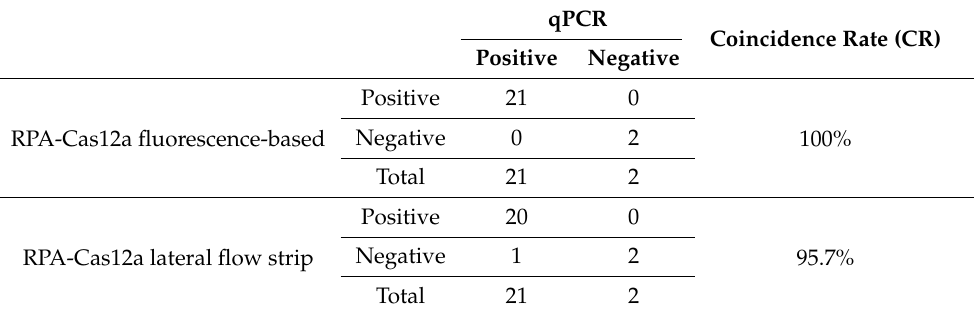
Figure 6. Evaluation of RPA-CRISPR/Cas12a assay for MRSA with 23 clinical isolates. ( a ) Real-time fluorescence-based one-tube RPA-CRISPR/Cas12a detection of MRSA and selection of fluorescence of CRISPR reactions for 10 min for heat map, validated by qPCR in parallel. Samples 8 and 16 are negative, the rest are positive. × : indicates a negative sample. NTC: no template control. ( b ) Endpoint visualization fluorescence-based one-tube RPA-CRISPR/Cas12a detection of MRSA. The only samples that do not show fluorescence signals are samples 8 and 16. ( c ) Detection of MRSA in clinical isolates with the RPA-CRISPR/Cas12a LFS assay. Test lines are visible on all samples except samples 8, 16 and 22, which do not show test lines. Table 1. Clinical validation of one-tube RPA-CRISPR/Cas12 detection for the